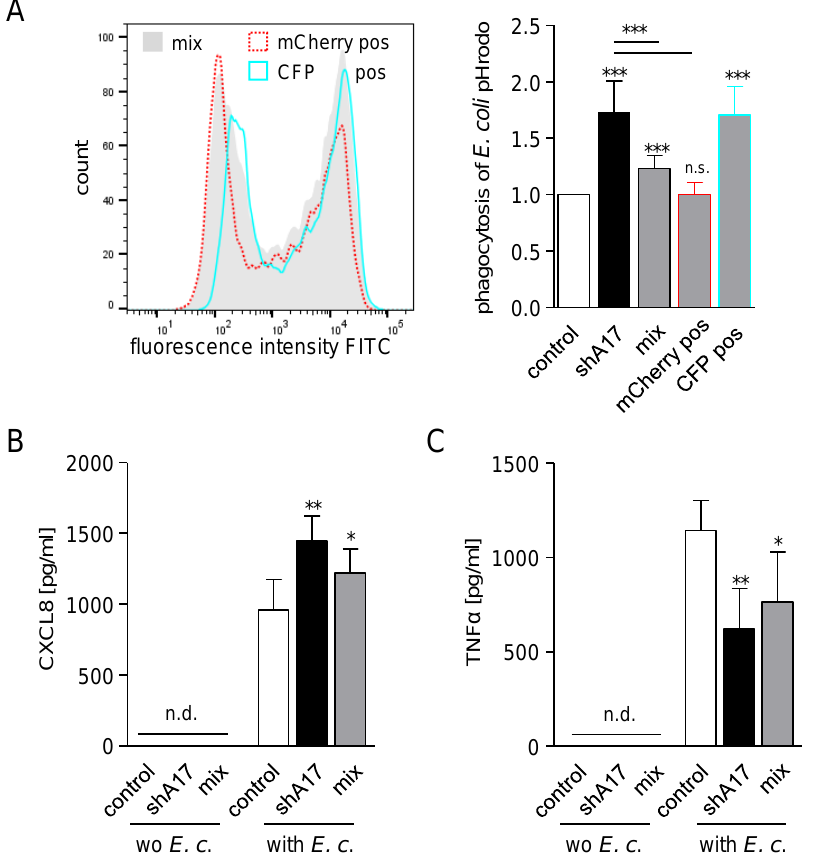
Figure 5. Knockdown of ADAM17 enhances phagocytosis in a cell autonomous manner, ( A ) THP-1 cells were transduced with lentivirus encoding control-shRNA (control, mCherry pos) or ADAM17- shRNA (shA17, CFP pos). A17 KD cells (black), control cells (white) and a 1:1 mixture of both (grey) were then exposed to E. coli pHrodo green and assayed for phagocytosis by flow cytometry. The geometric mean fluorescence of the cells was calculated in relation to that of the indicated control. Mixed cells were additionally gated for mCherry-positive (control – shRNA) or CFP-positive (ADAM17 – shRNA) cells and reanalysed for their bacterial uptake. ( B , C ) Additionally, cells described in ( A ) were analysed for their CXCL8 ( B ) and TNFα ( C ) release by ELISA. Release could not be detected (n.d.) in the absence of E.coli. Data are shown as mean and SD of at least four independent experiments ( A ) n = 5; ( B , C ) n = 4). Significant differences compared to the respective control are indicated as asterisks (* p < 0.05, ** p < 0.01, *** p < 0.001) and additional comparisons are specified by bars.